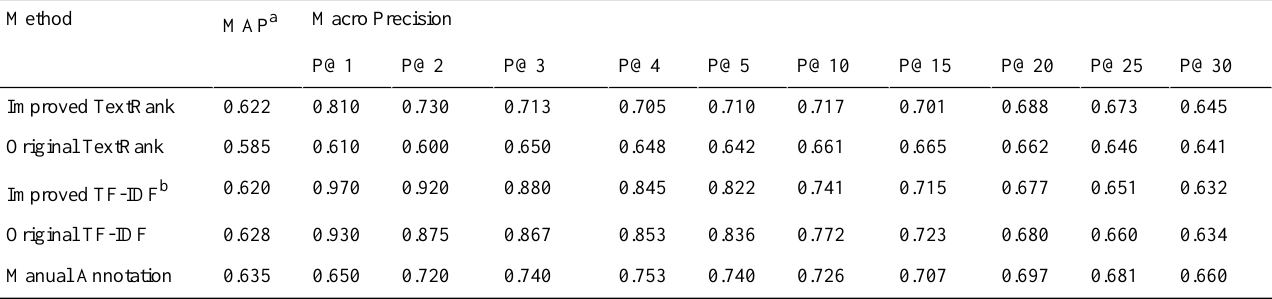
Table 5. Performance comparison among different keyword extraction algorithms for n=50 evaluations